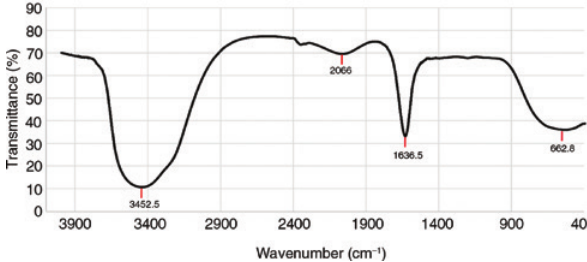
Figure 1: Fourier transform-infrared (FT-IR) spectrum of Pelargonium zonale leaves extract (PLE).